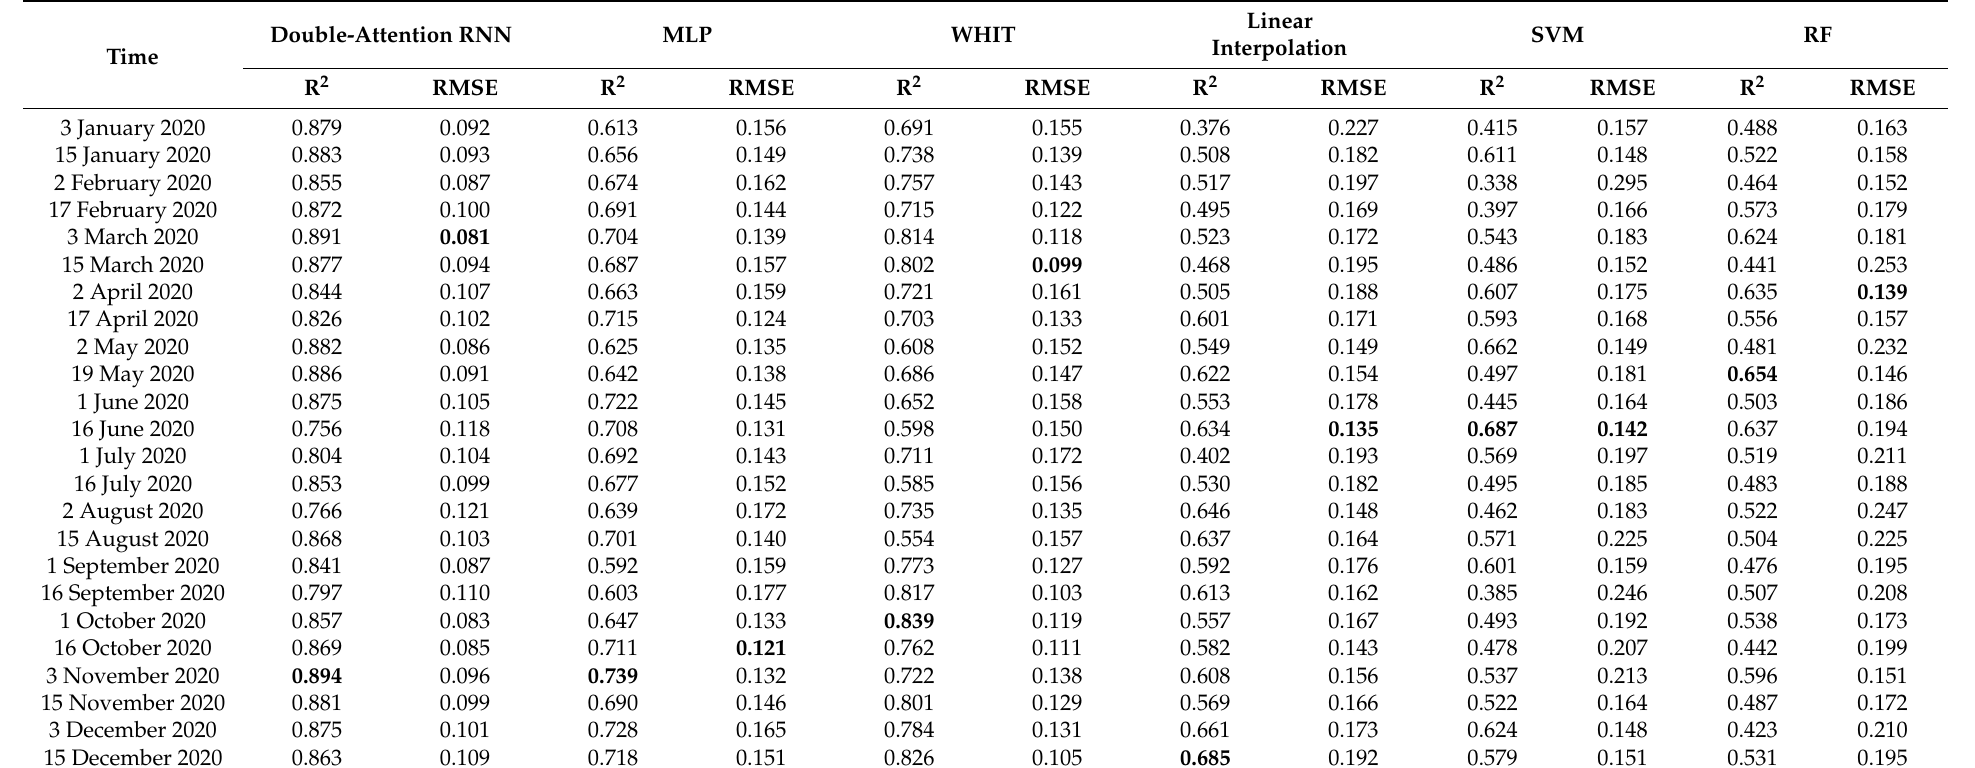
Table 2. Accuracy evaluation table of comparative models. Bold numbers indicate the best metric values of each model in 2020. Double-Attention RNN Time